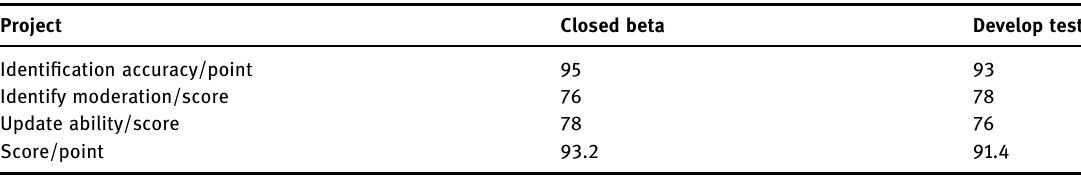
Table 4: Evaluation results of the algorithm in this article